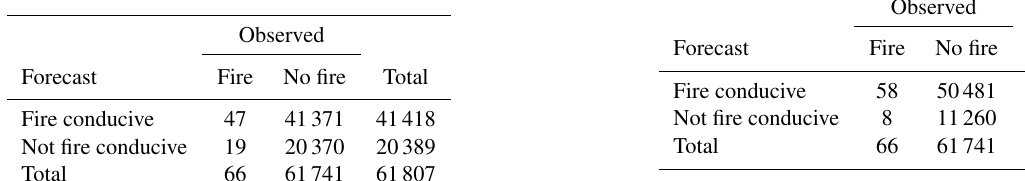
Table 3. Contingency table for the midnight 12h NWP-derived fire weather index (FWI) component forecast for 2 May 2011, classified using the percentile-based FDRS. Each 2km × 2km grid cell within Great Britain is represented as a unit value, and assigned to one ele- ment of the 4 × 4 matrix below, based upon whether a fire is burning in that particular grid cell, and whether fire danger conditions are conducive to fire. For the purpose of this analysis, grid cells where the FWI value > 90th percentile were considered to be conducive to fire. Wildfire observations are taken from the IRS database. Hit rate ( H ) = 0.88, false-alarm rate ( F ) = 0.82, extremal dependence index (EDI) =